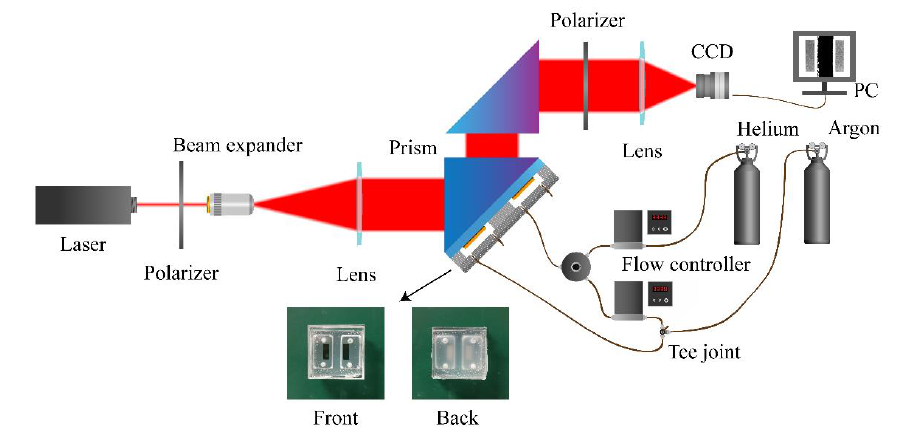
Figure 1. Phase interference surface plasmon resonance (SPR) sensor for inert gas